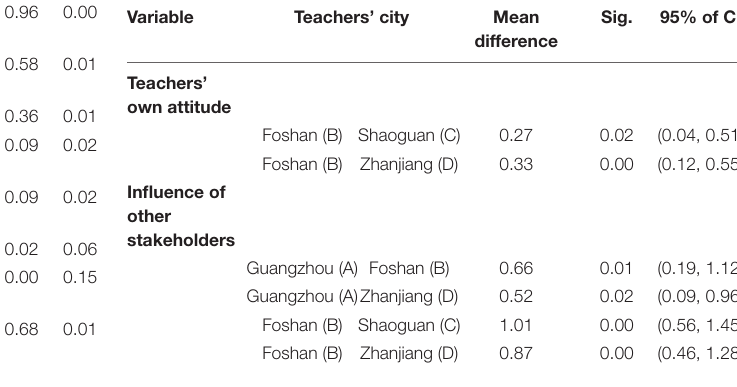
TABLE 6 | Post hoc tests on the differences between